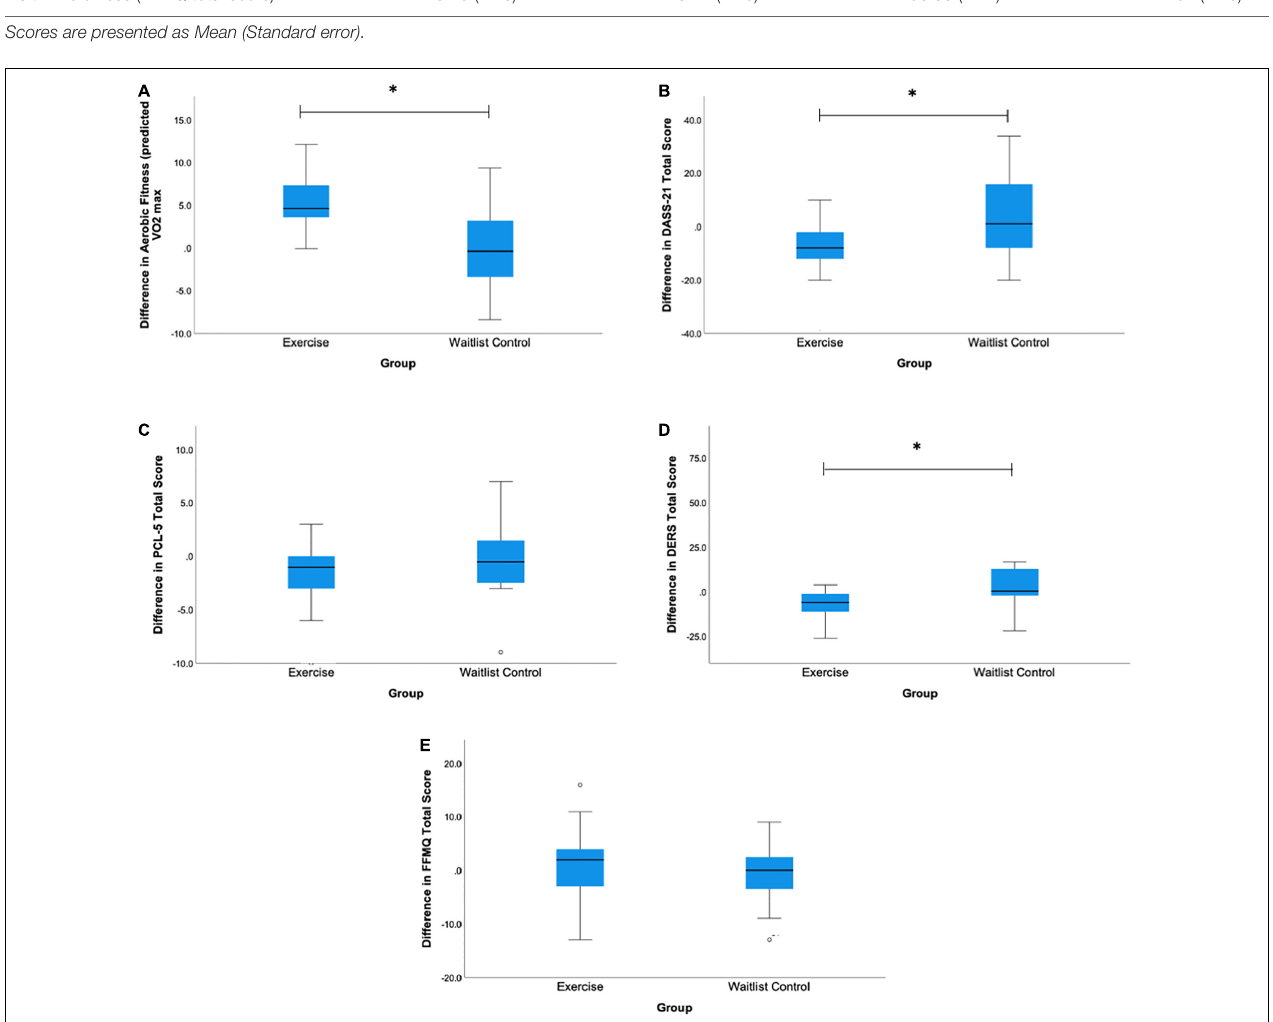
FIGURE 1 | Boxplots of mean difference scores for the exercise and waitlist control groups for (A) Aerobic fitness (predicted VO 2 Max), (B) DASS-21 Total Score, (C) PCL-5 Total Score, (D) DERS Total Score, and (E) FFMQ Total Score. Difference scores were calculated by taking the post-intervention score minus the pre-intervention score for each measure for each group. *A significant difference between groups at p <